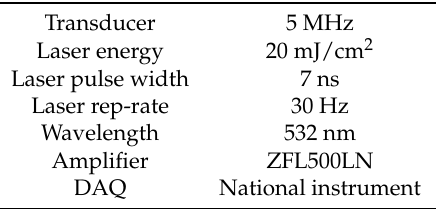
Figure 3. Low-cost photoacoustic computed tomography (LC-PACT) system diagram comprised of an Nd:YAG 30Hz Spectra Physics laser, an optical parametric oscillator (OPO), a circular ring, a DC supply for the motor driver, an NI DAQ, an NI trigger, a servo motor, a motor gear, a three-axis translation stage for phantom, and a transducer-amplifier unit. Table 1. Specification of the experimental setup presented in Figure